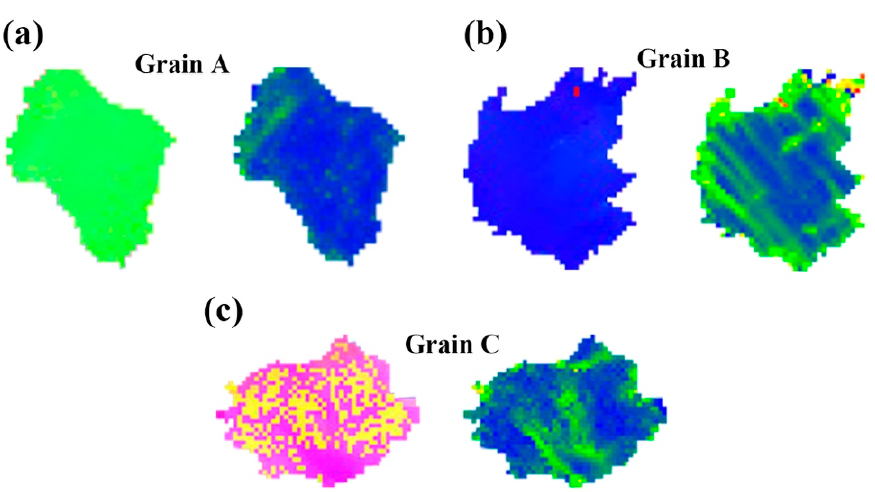
Figure 12. Basal slip Schmid factor (SF) distribution of three alloys: ( a , d ) Alloy A, ( b , e ) Alloy B, ( c , f ) Alloy C.